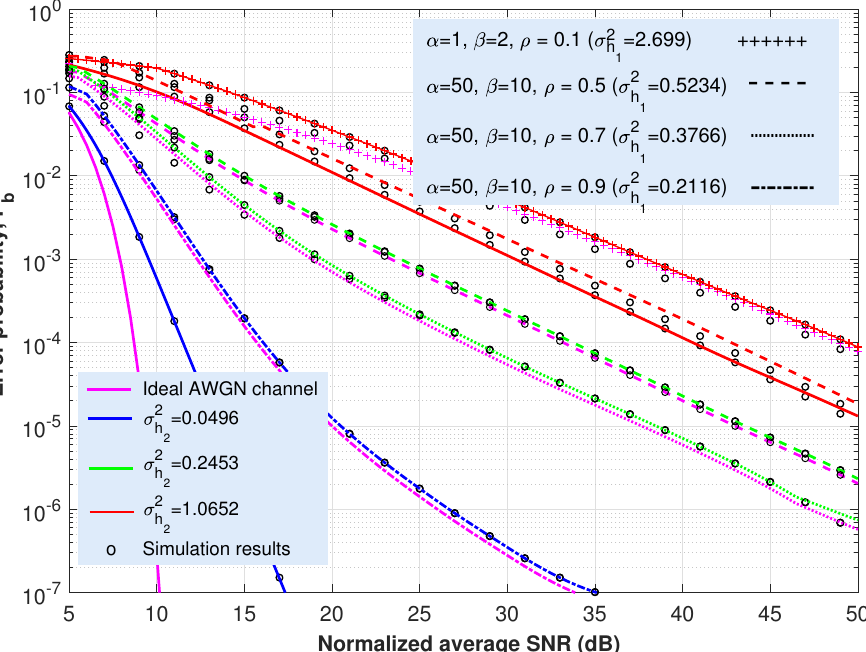
Figure 3. Analytical average bit error rate (ABER) and Monte Carlo simulation results (circles) vs. = 0.0496), weak-to-moderate ( σ 2 = 0.2453) SINR γ 0 for a conventional OOK format under weak ( σ 2 h 2 h 2 = 1.0652) salinity induced turbulence and different Málaga turbulence intensities in and strong ( σ 2 h 2 the terrestrial FSO link. Scenarios and values of irradiance variances in the underwater medium are taken from acquired data presented in [68]. In solid lines, the performance of the system when only oceanic turbulence is considered is represented. As a reference, the ideal AWGN channel is depicted with a solid